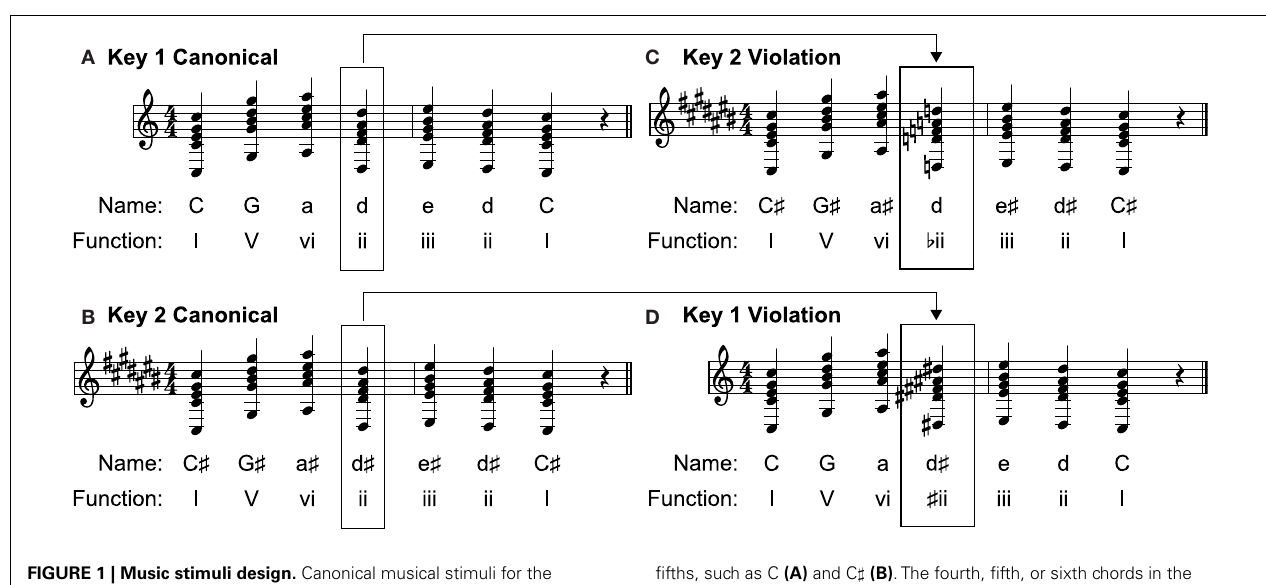
FIGURE 1 | Music stimuli design. Canonical musical stimuli for the blatant condition were created by spelling out a relative chord progression in two keys separated by five degrees on the circle of